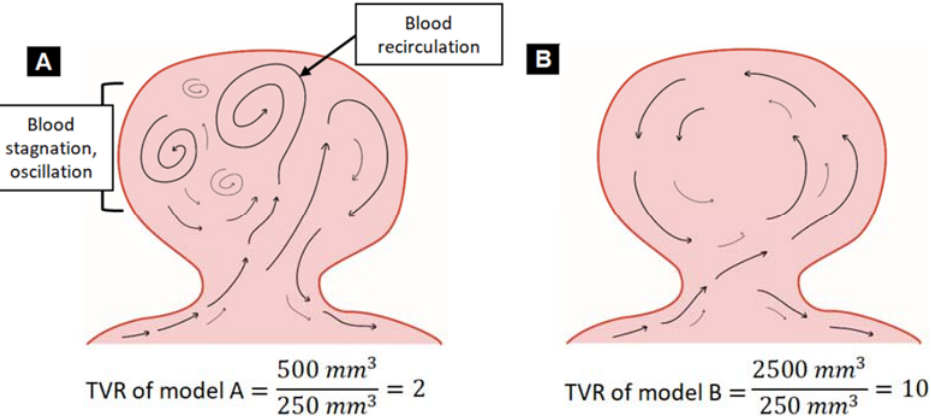
Figure 2. Two examples of a newly developed hemodynamic risk factor, total volume ratio (TVR). ( A ) TVR of model A shows lower TVR compared to model B due to blood recirculation, blood stagnation, and oscillation. ( B ) TVR of model B shows higher TVR compared to model A.